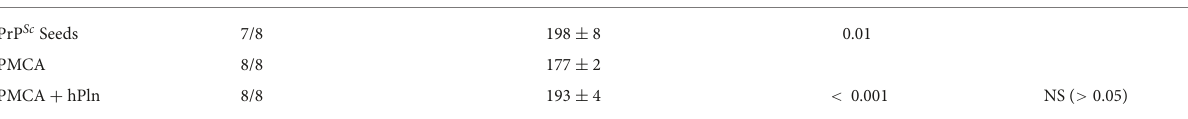
TABLE 1 Bioassay of PMCA materials with or without supplementation with plasmin.